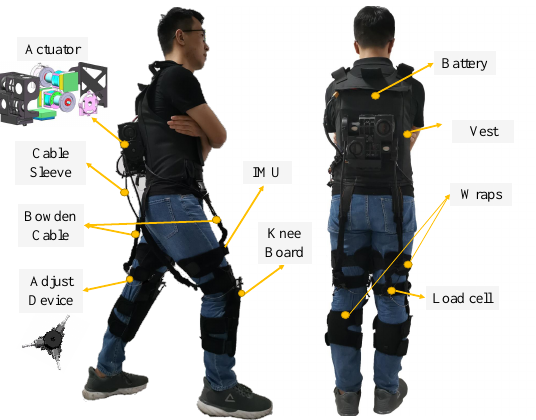
Figure 1. The system overview showing the structure of the soft exoskeleton and the position of each of its